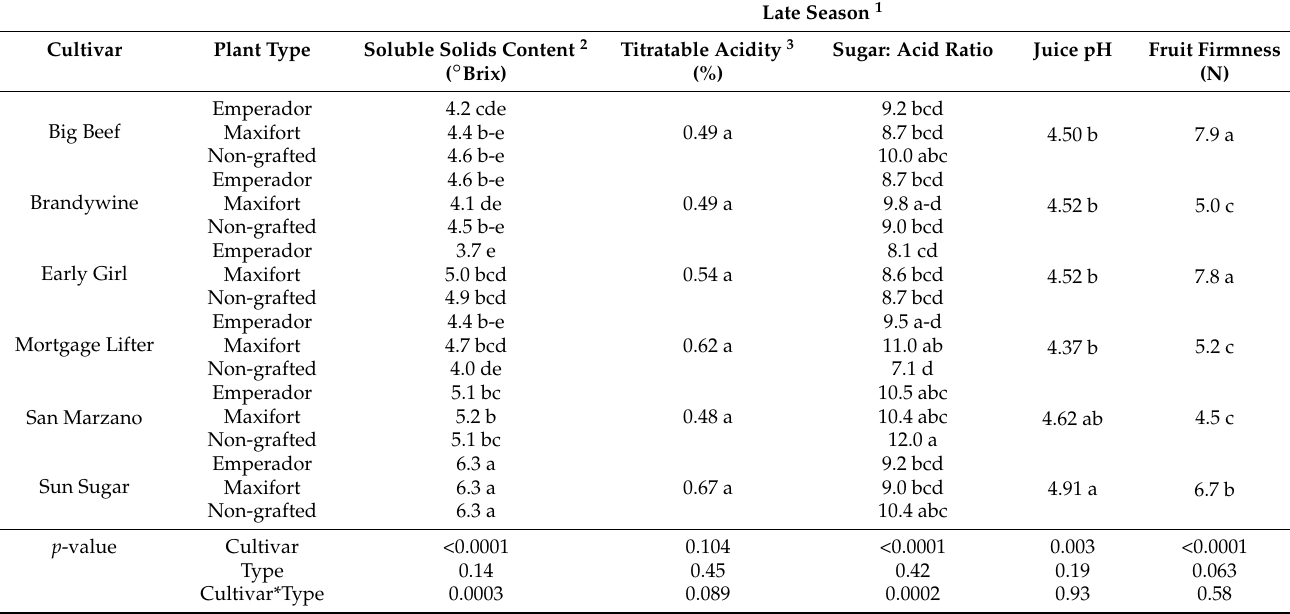
Table 5. Fruit quality variables in six tomato cultivars when grafted onto two types of rootstocks or grown non-grafted in a high tunnel during late